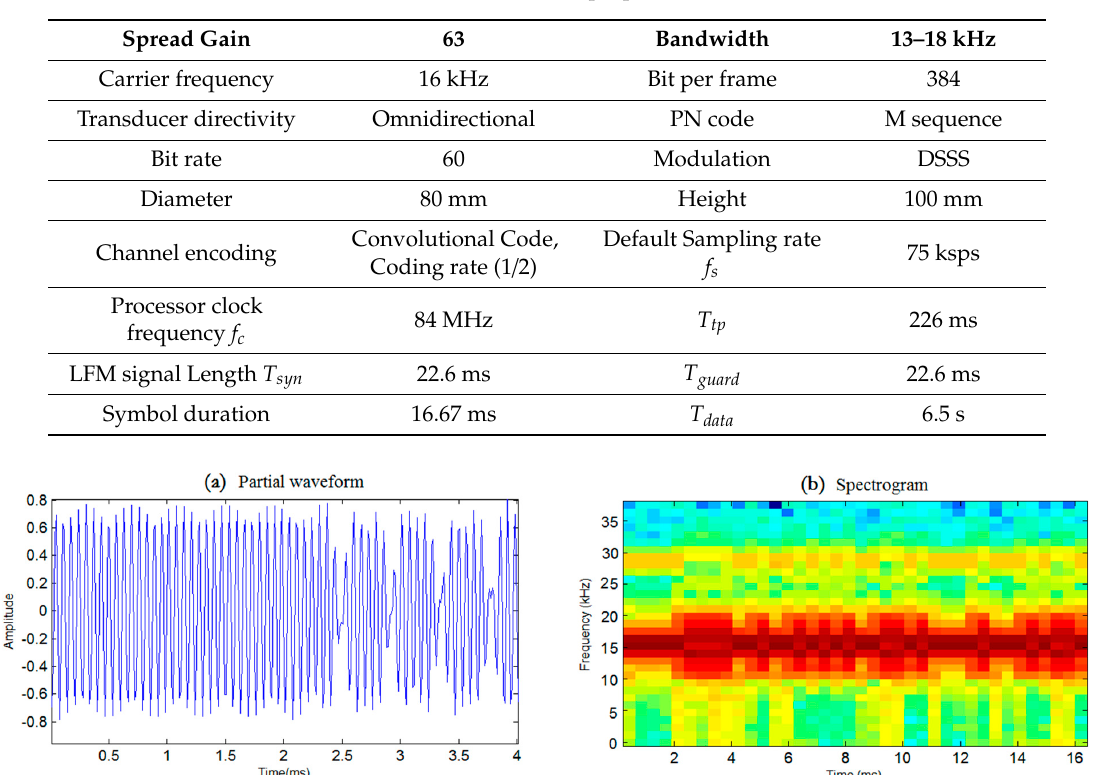
Figure 2. Frame structure of the modem signal. LFM = linear frequency modulation. Table 1. Parameters of the proposed modem.